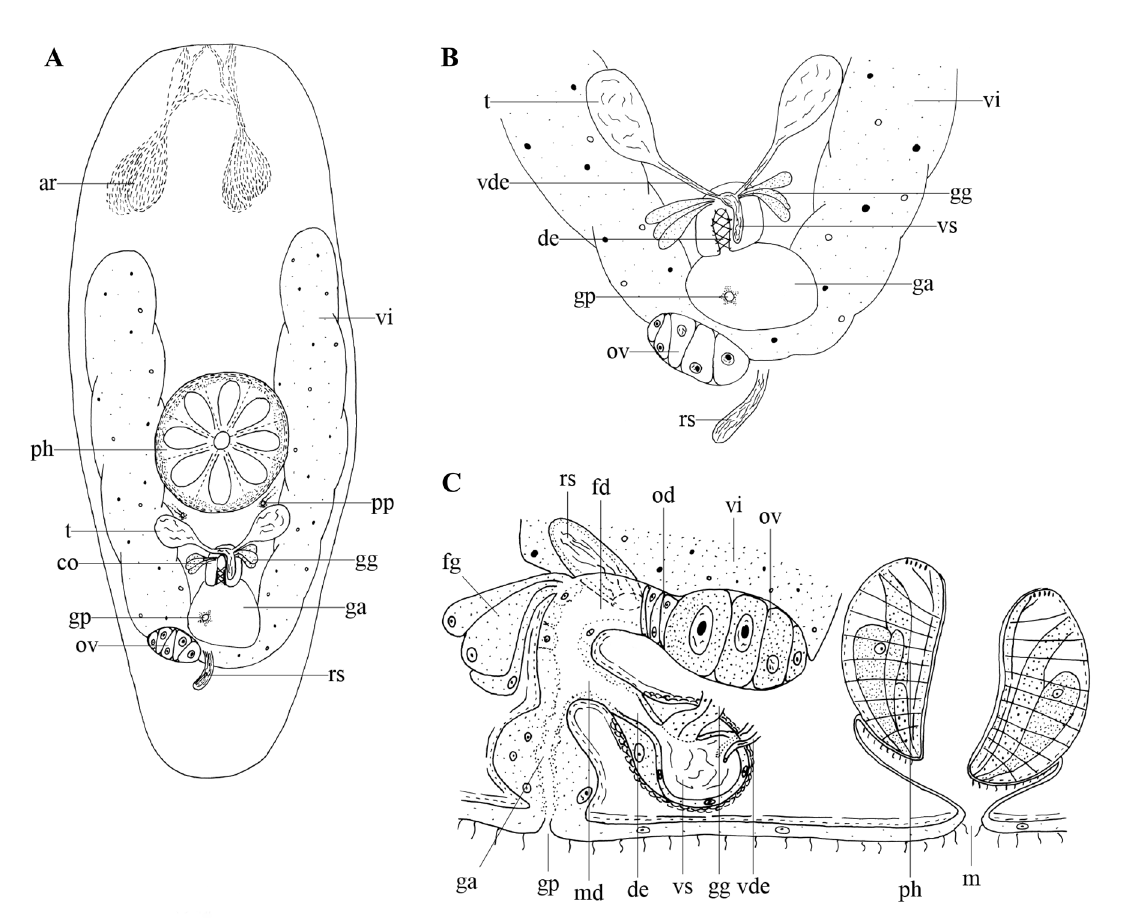
Fig. 11. Protoplanella simplex Reisinger, 1924. A . Internal organisation of a live specimen. B . Organisation of the genital system of a live specimen. C . Reconstruction of reproductive organs based on sagittal sections of the neotype (neotype no.